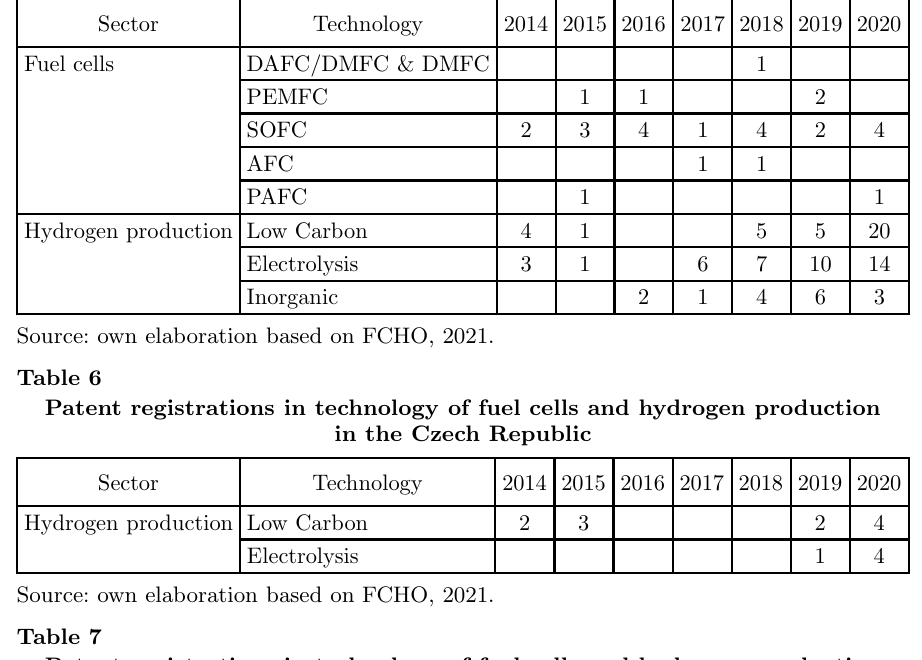
Patent registrations in technology of fuel cells and hydrogen production